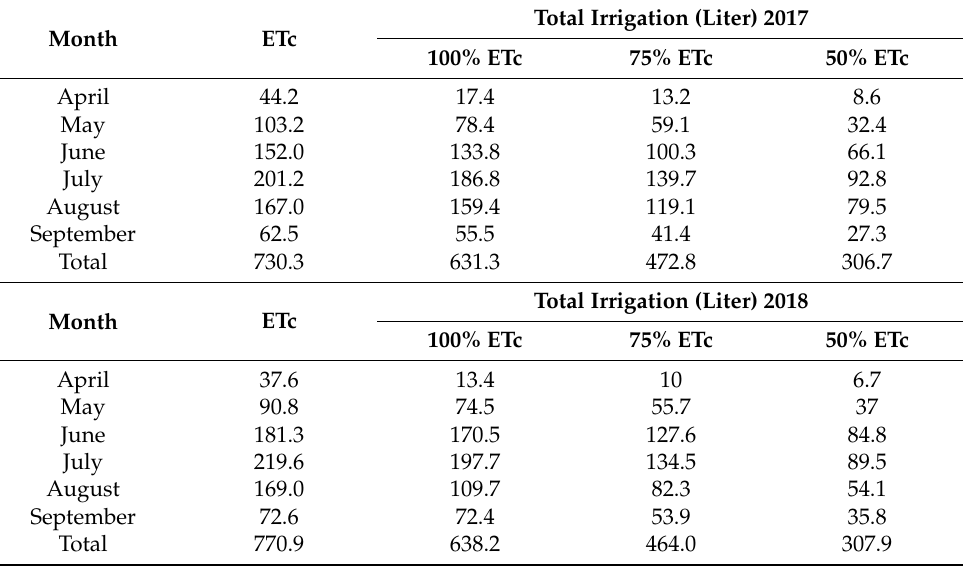
Table 3. Monthly water requirement at three ETc levels (100%, 75%, and 50%) for high density apple plantation (2017 and